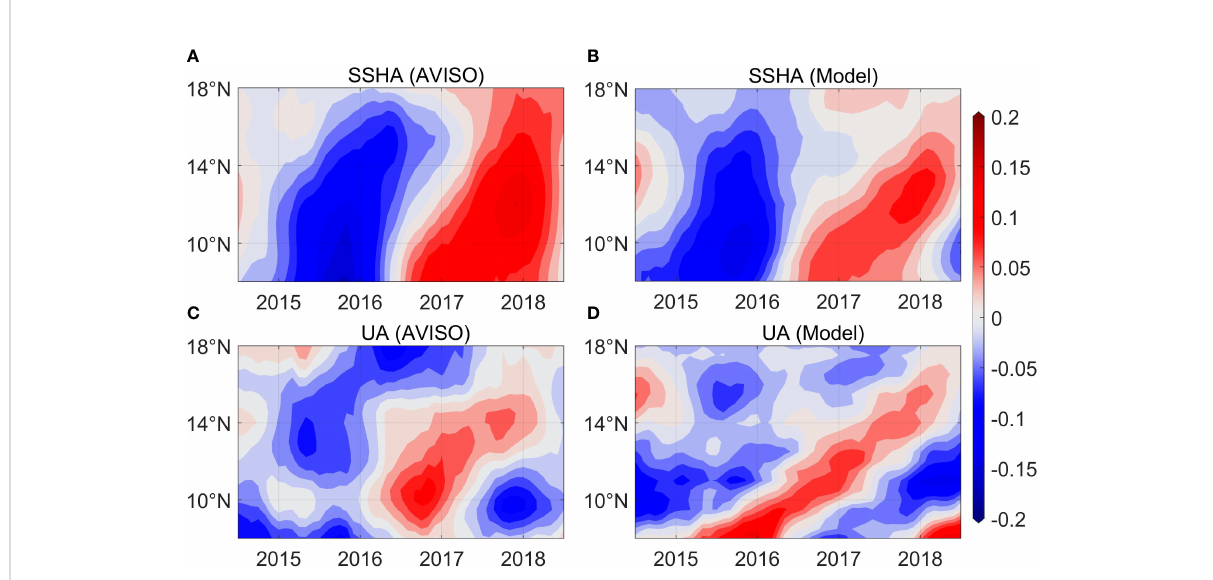
FIGURE 6 Time-latitude diagrams of the SSHA (a, m) and zonal geostrophic velocity anomalies (c, m/s) at 130°E derived from AVISO products. (B) and (D) are same as (A) and (C) , but from reduced gravity model simulations.